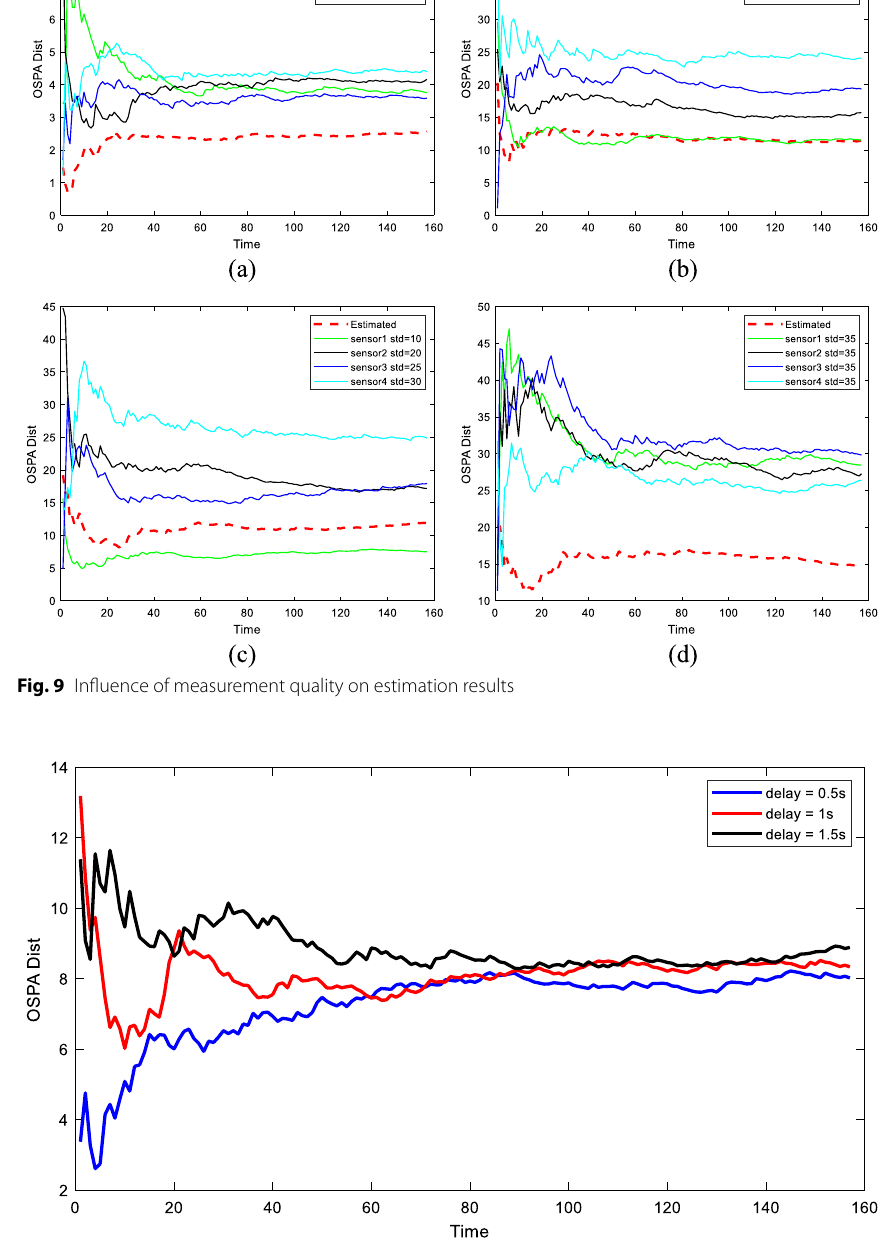
Fig. 10 Influence of asynchronous time on estimation